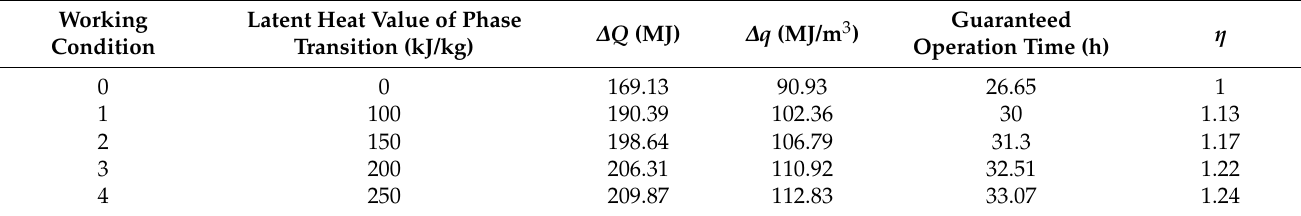
Table 5. Effect of the latent heat value on the performance of the reservoir.